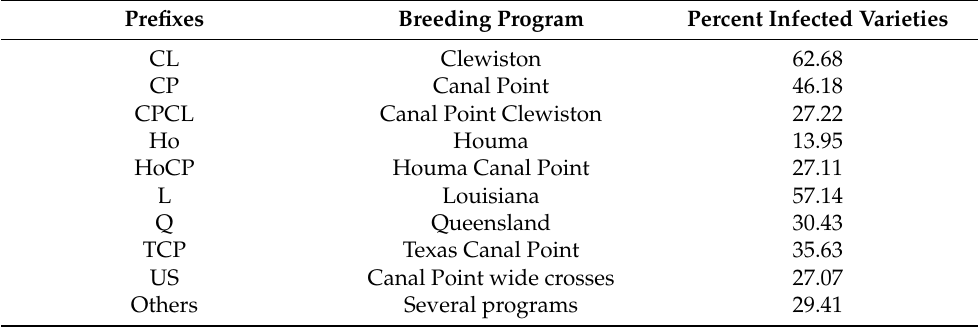
Table 2. Percent incidence of sugarcane yellow leaf virus in the Canal Point breeding